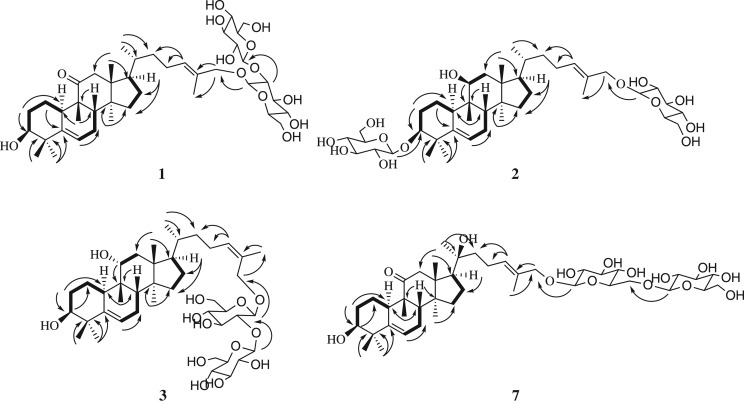
Key 1H-1H COSY (bold bonds) and HMBC (arrows) correlations for compounds 1–3 and 7.